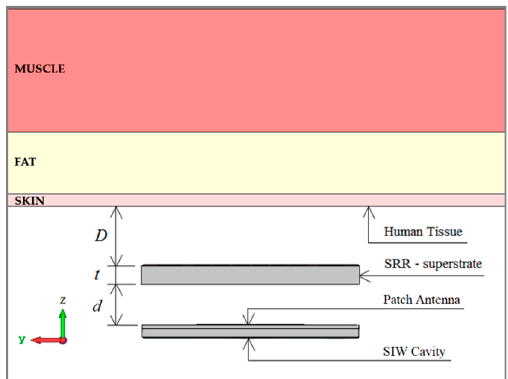
Figure 6. Sideview of SIW cavity-backed patch antenna with SRR superstrate placed at distance D from human tissue. Table 3. Electromagnetic parameters human tissue at f = 11 GHz. Biological